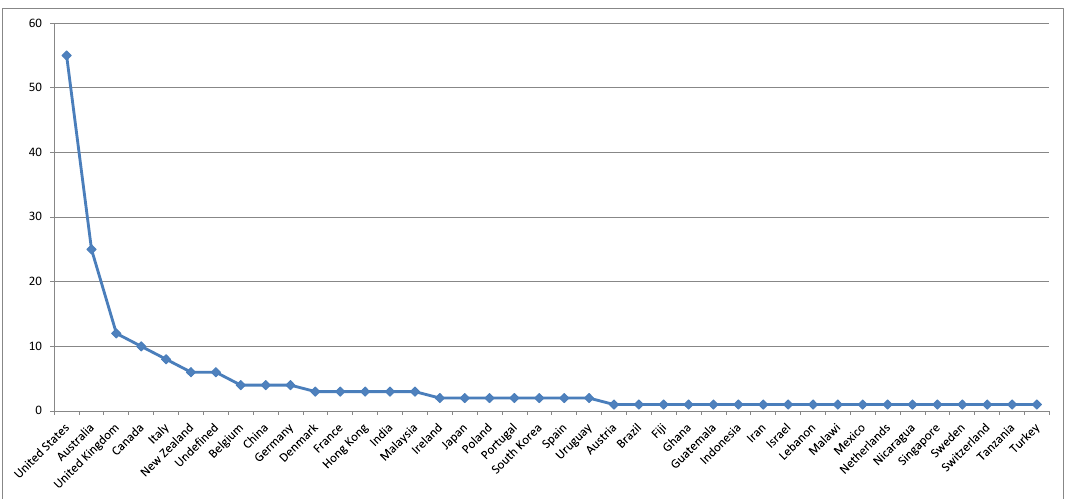
Figure 3. Distribution of the documents across countries.